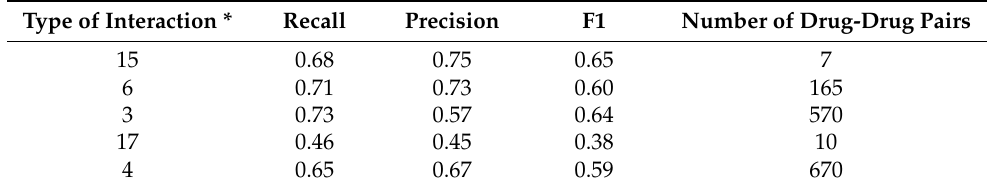
Table 4. XGBoost classifier performance on the validation